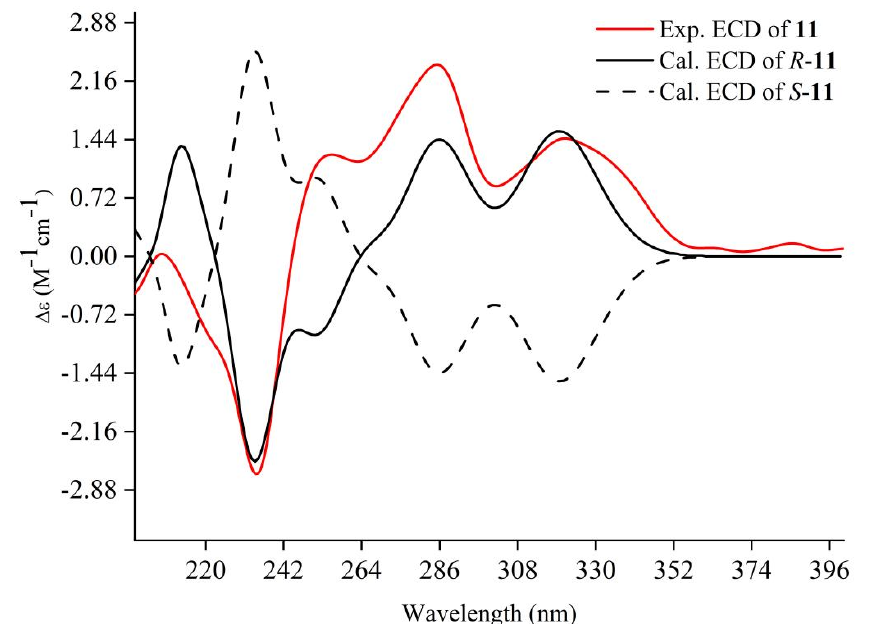
Figure 9. Experimental ECD spectra (200–400 nm) of 11 in methanol and the calculated ECD spectra of the model molecules of 11 at the PBE0/def2-TZVP